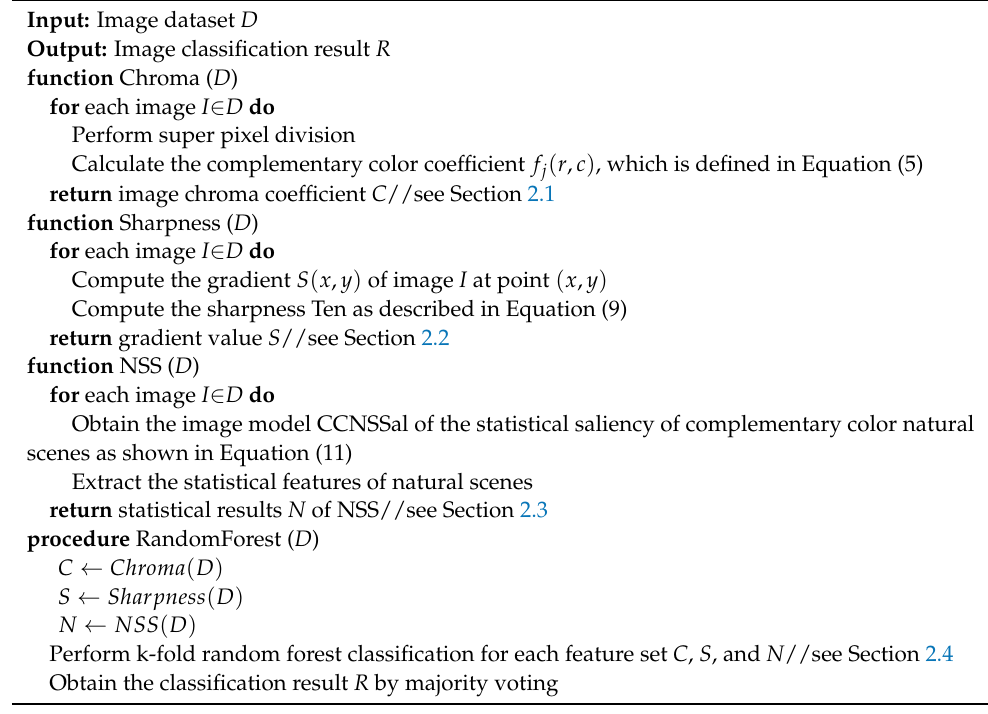
Algorithm 1: A descriptive script of the proposed stitching tampered/untampered image classification